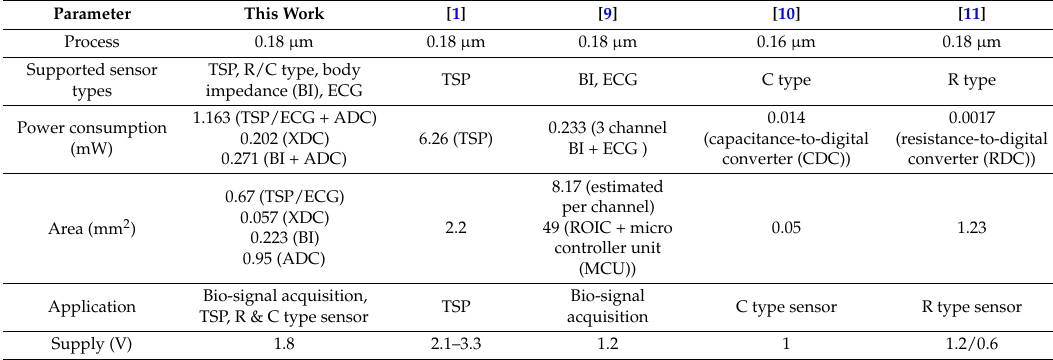
Table 1. Performance summary and comparison with recent works.